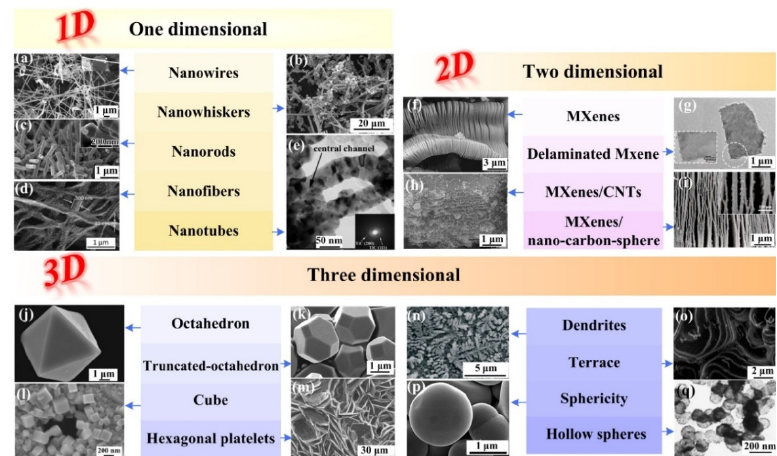
Figure 1. Various morphologies of titanium carbides with different dimensionalities reported recently and some of their applications. One dimensional: With permission from Reference [7], copyright (2013) Elsevier. With permission from Reference [8], copyright (2011) American Chemical Society. With permission from Reference [10], copyright (2015) Elsevier. With permission from Reference [22], copyright (2018) Elsevier. With permission from Reference [23], copyright (2010) Royal Society of Chemistry; Two dimensional: With permission from Reference [3], copyright (2018) Royal Society of Chemistry. With permission from Reference [12], copyright (2012) American Chemical Society. With permission from Reference [24], copyright (2019) American Chemical Society. With permission from Reference [25], copyright (2017) Royal Society of Chemistry; Three dimensional: With permission from Reference [13], copyright (2009) American Chemical Society. With permission from Reference [15], copyright (2012) Royal Society of Chemistry. With permission from Reference [16], copyright (2008) Elsevier. With permission from Reference [26], copyright (2017) the authors. With permission from Reference [17], copyright (2017) Royal Society of Chemistry. With permission from Reference [18], copyright (2011) Elsevier. With permission from Reference [27], copyright (2004)